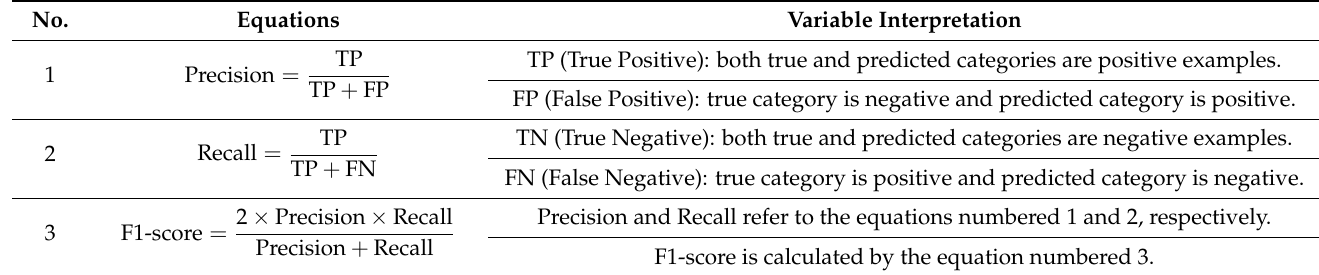
Table 1. Description of model validation